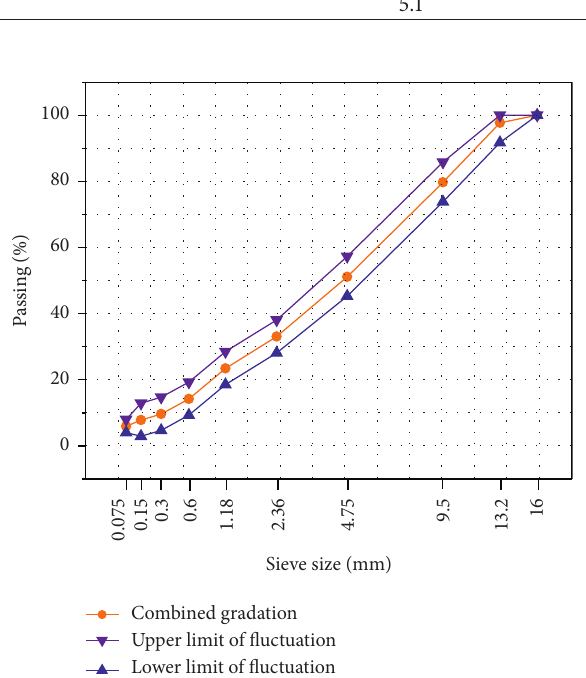
Figure 15: Gradation by online detection of the asphalt mixture